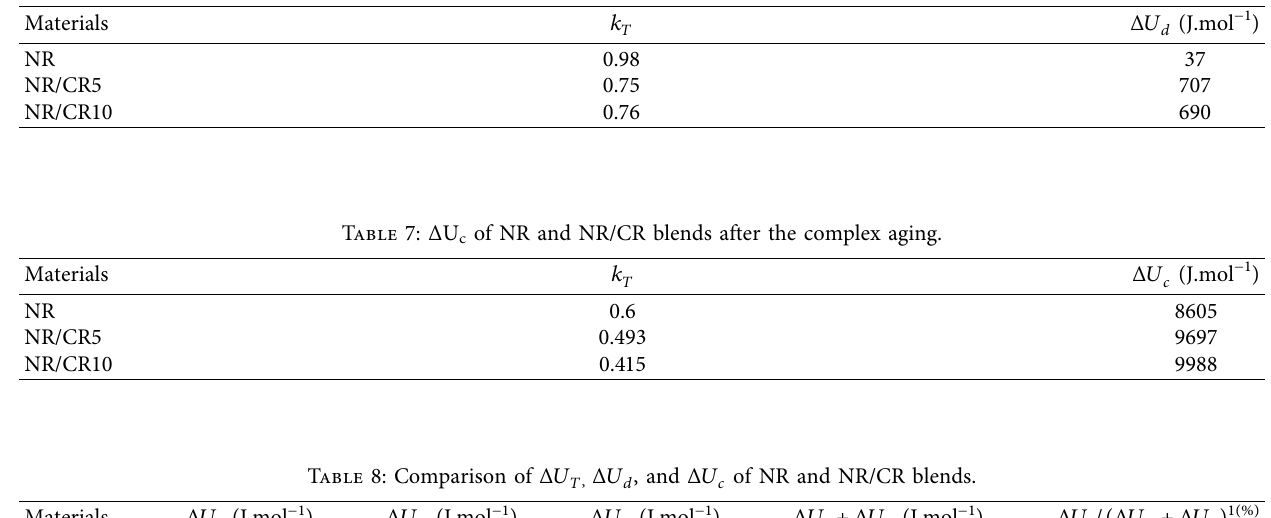
U U T , Δ d , and Δ c of NR and NR/CR blends.